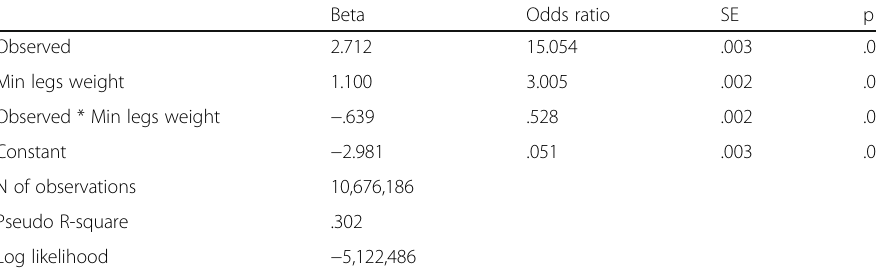
Table 3 Logistic regression estimation of triadic closure